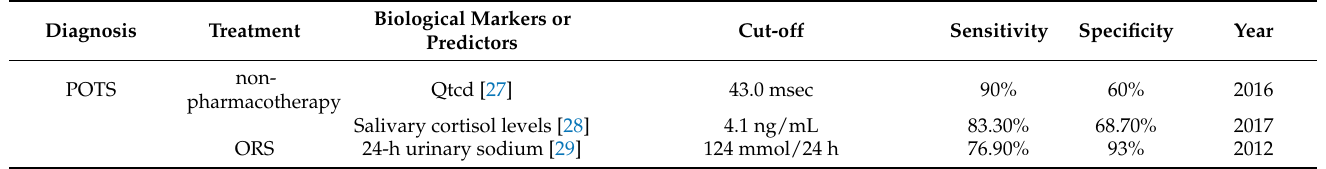
Table 2. Clinical indicators used to predict individualized treatment of POTS and